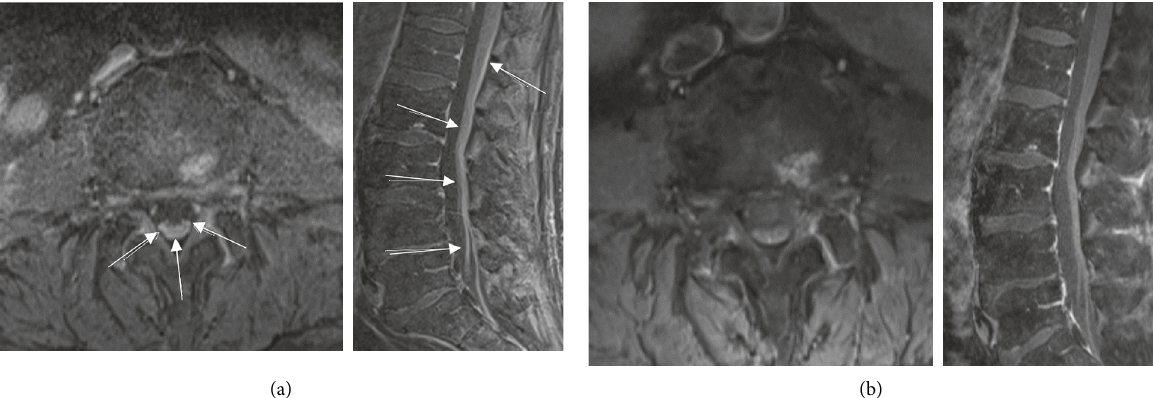
Figure 2: (a) Pretreatment axial and sagittal T1 weighted fat saturated postcontrast images show abnormal enhancement along the dorsal aspect of the spinal cord at the level of L1 and L2, with abnormal enhancement along the cauda equina nerve roots. Findings are highly suspicious for leptomeningeal disease with a differential of infectious and inflammatory etiologies. (b). Post-treatment axial and sagittal T1 weighted fat saturated postcontrast images show markedly improved enhancement at the level of L1 and L2 and of the conus medullaris and cauda equina nerve roots, with very subtle minimal